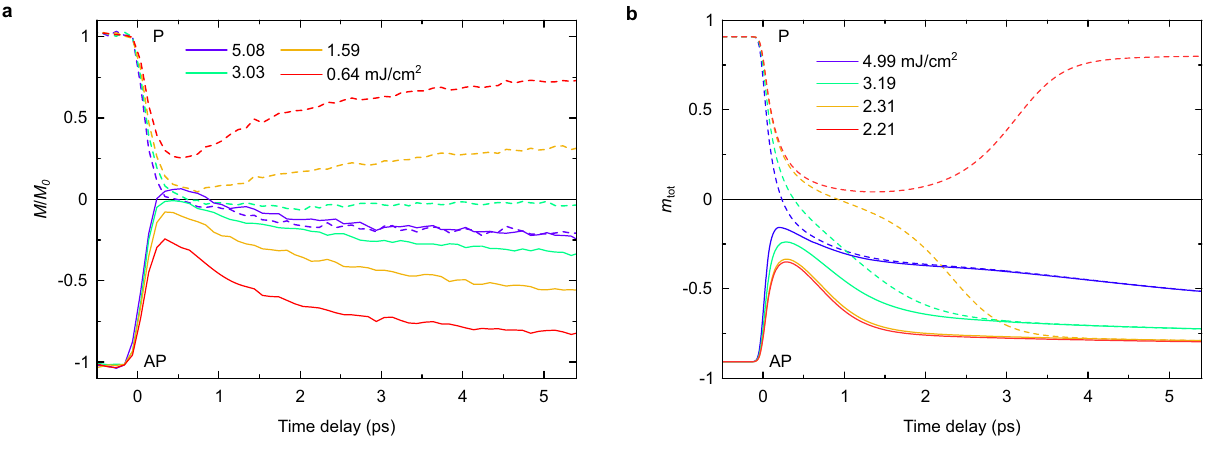
fourdifferent fl uencesasindicated. b Resultsobtainedfromthesimulationswhere m tot includes the normalized magnetization coming from both localized and itinerant electrons in the s-d